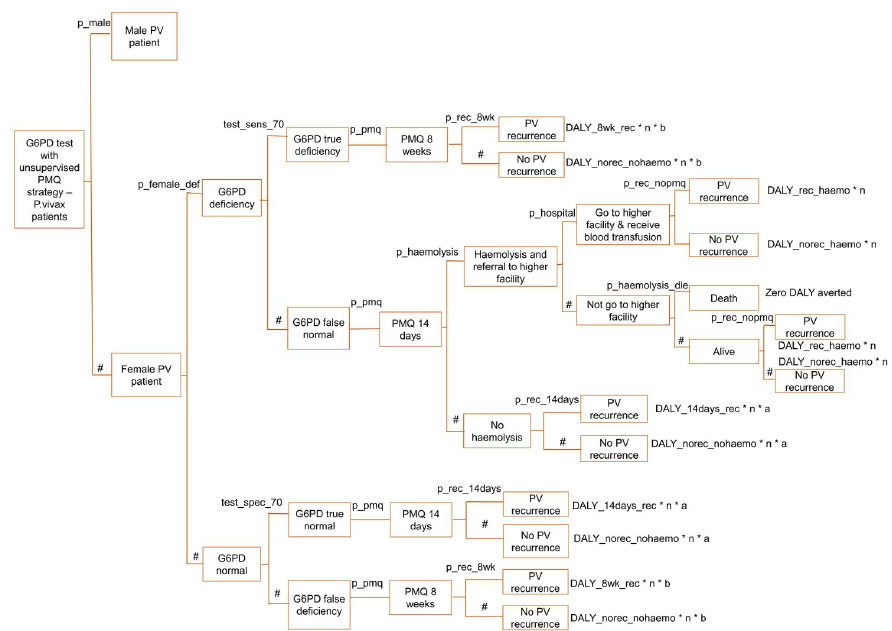
Fig 4. Decision tree model for G6PD test with unsupervised PMQ strategy—Female arm.